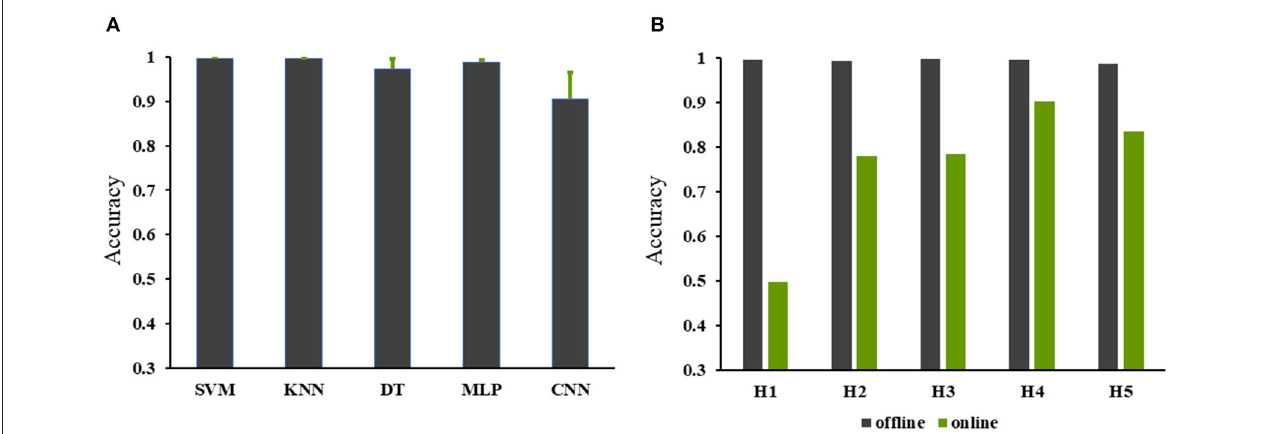
FIGURE 8 | The online and offline classification accuracies. (A) The accuracies of the offline classification for classifier selection; (B) the accuracies of the online and offline classifications for real-time control of exoskeleton using the support vector machine (SVM).